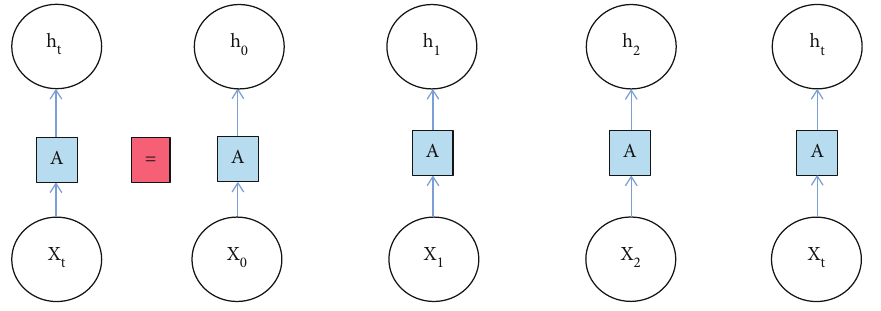
Figure 4: Recurrent neural network (RNN) logic.